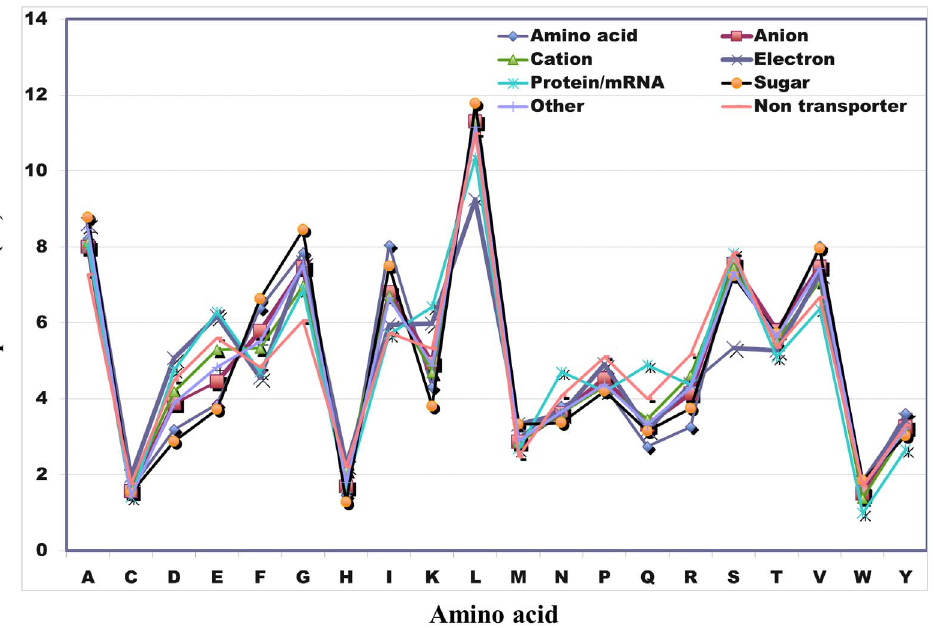
Figure 1. Amino acid composition of transporter proteins. The amino acid composition for each amino acid as a percentage of the total number of amino acids for amino acid transporters (blue diamonds), anion transporters (red squares), cation transporters (green triangles), electron transporters (purple x), protein/mRNA transporters (cyan asterisks), sugar transporters (orange circles), other transporters (plus signs), and non- transporters (orange dashes) are plotted.